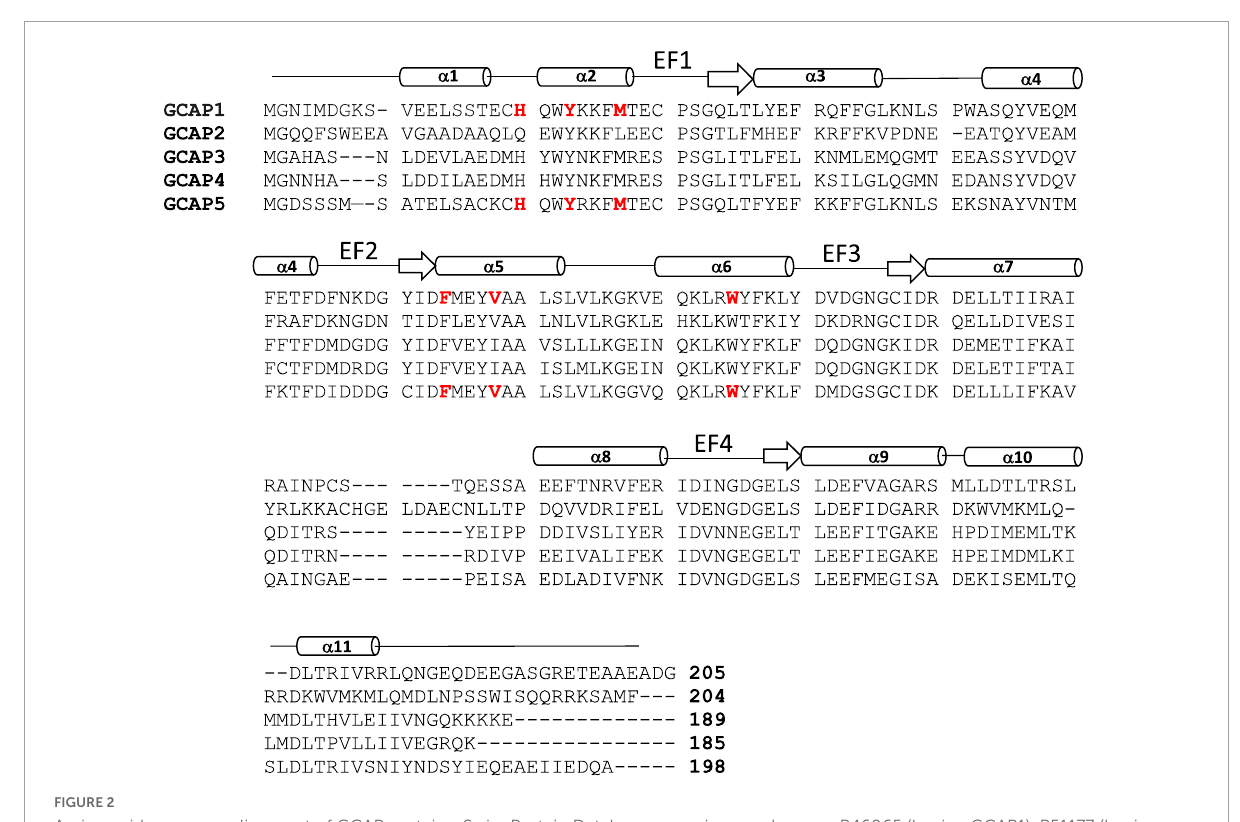
FIGURE2 Amino acid sequence alignment of GCAP proteins. Swiss Protein Database accession numbers are P46065 (bovine GCAP1), P51177 (bovine GCAP2), O95843 (zebrafish GCAP3), Q6ZM98 (zebrafish GCAP4), and Q5MAC8 (zebrafish GCAP5). Exposed “hot spot” residues in GCAP1 and GCAP5 are highlighted red. Secondary structure (helices and strands) are shown above the sequence alignment depicted as cylinders and